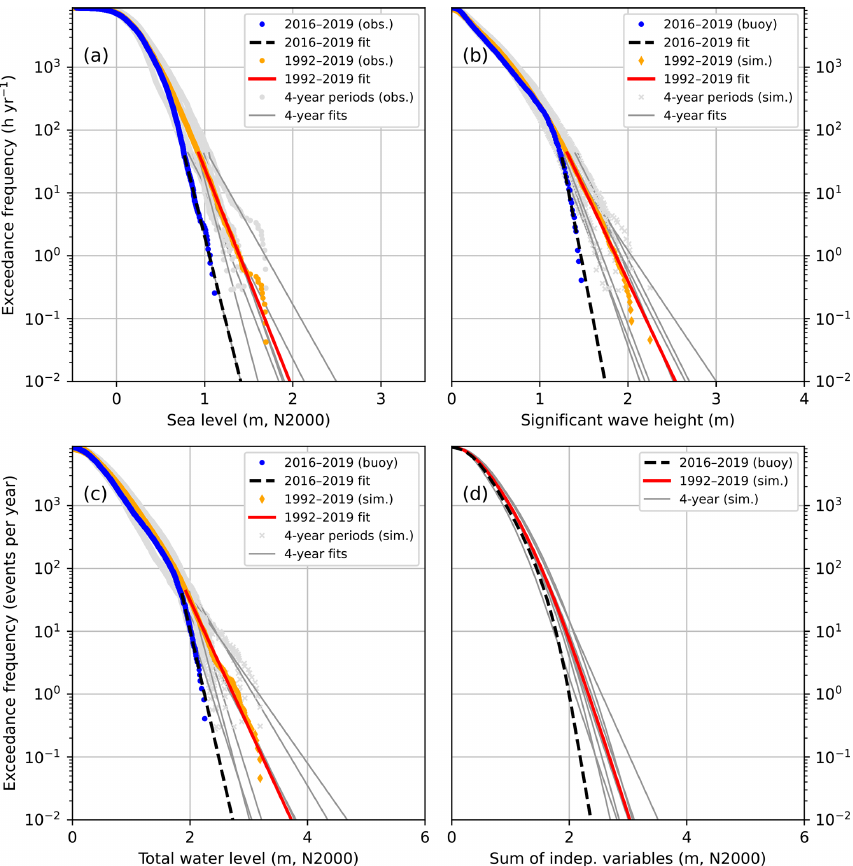
Figure 6. The CCDFs of (a) observed hourly sea levels, (b) observed/simulated significant wave heights, (c) total water level as their sum, and (d) total water level calculated as a sum of two independent variables. The distributions shown are those for the data set F (ice-free season). The distributions were extrapolated with exponential functions below the exceedance frequency of 44hyr − 1 . The seven consecutive 4-year periods shown separately for observed sea levels and simulated waves are 1992–1995 to